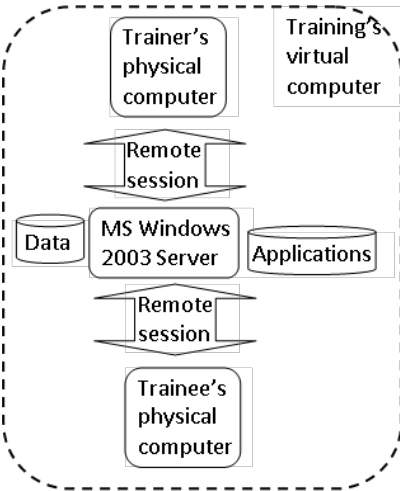
Fig. 3. Topology of virtual training computer based on remote sessions to the